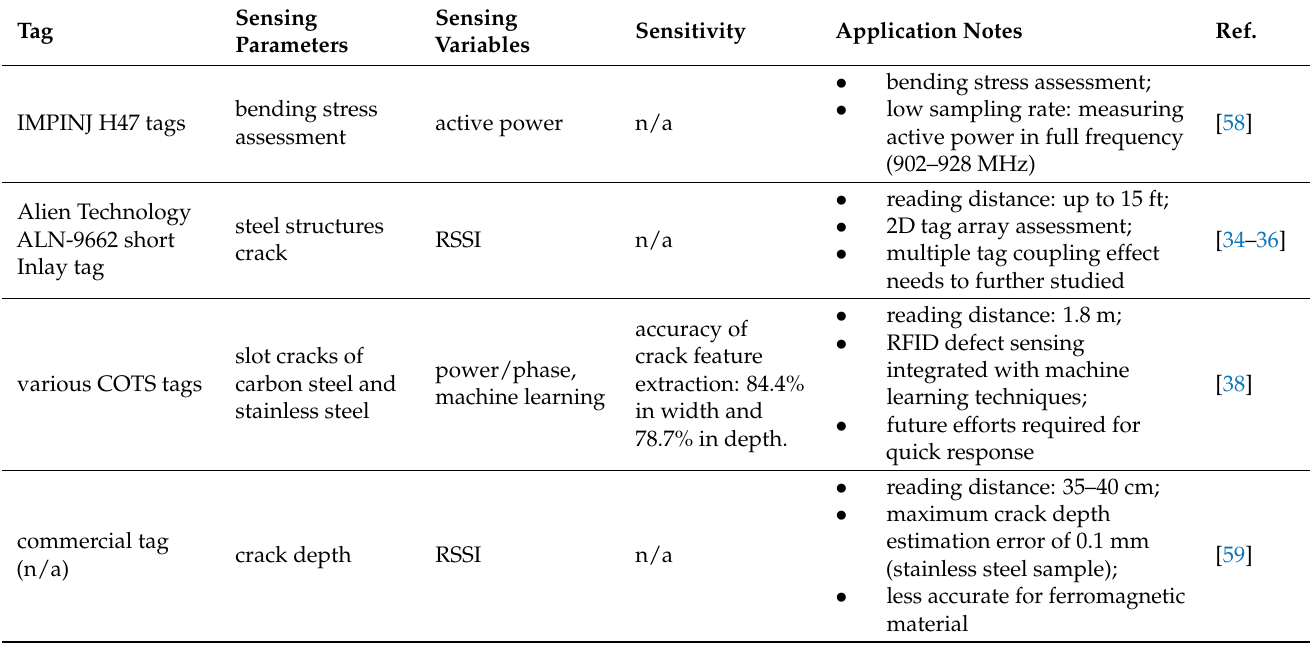
Table 3. COTS RFID sensor tags for